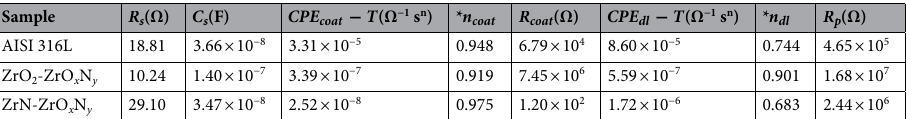
Table 4. Electrochemical parameters obtained from equivalent electrical circuits for the coating vs stainless steel.